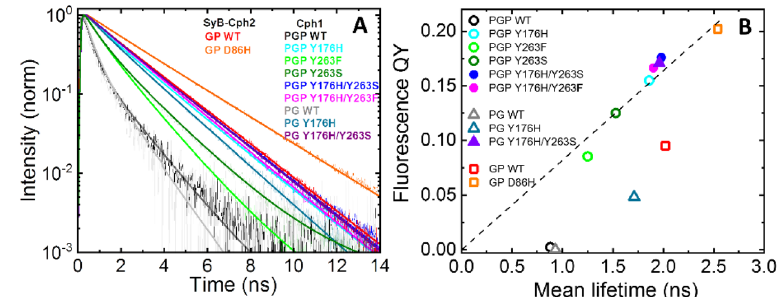
Figure 4. Fluorescence decay curves and correlation of fluorescence lifetimes with quantum yield. ( A ) Normalized fluorescence decay curves of Cph1 PGP, Cph1 PG, SyB -Cph2 GP and their variants. The unnormalized decay curves are shown in Fig. S6. The fit to a multi-exponential decay function (Eq. 2) is shown as a solid line. ( B ) Correlation between fluorescence quantum yield and mean fluorescence lifetime. The dotted line is to guide the eye. The slope of this line would correspond to the radiative rate k r according to the equation = k · τ and indicate a similar k � r f r for those data points that fall on this line. Conditions: 300 mM NaCl, 50 mM Tris/HCl pH 7.8, 19 °C; λ ex = 640 nm, and λ em = 708 ± 38